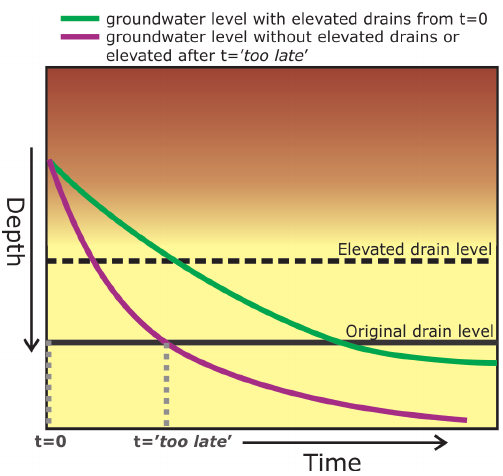
Figure 11. The crucial timing of elevating the overflow levels of controlled drainage at the end of the drainage season. Water can be conserved when the drain outlets are elevated before the groundwa- ter levels are below the drains and the discharge has